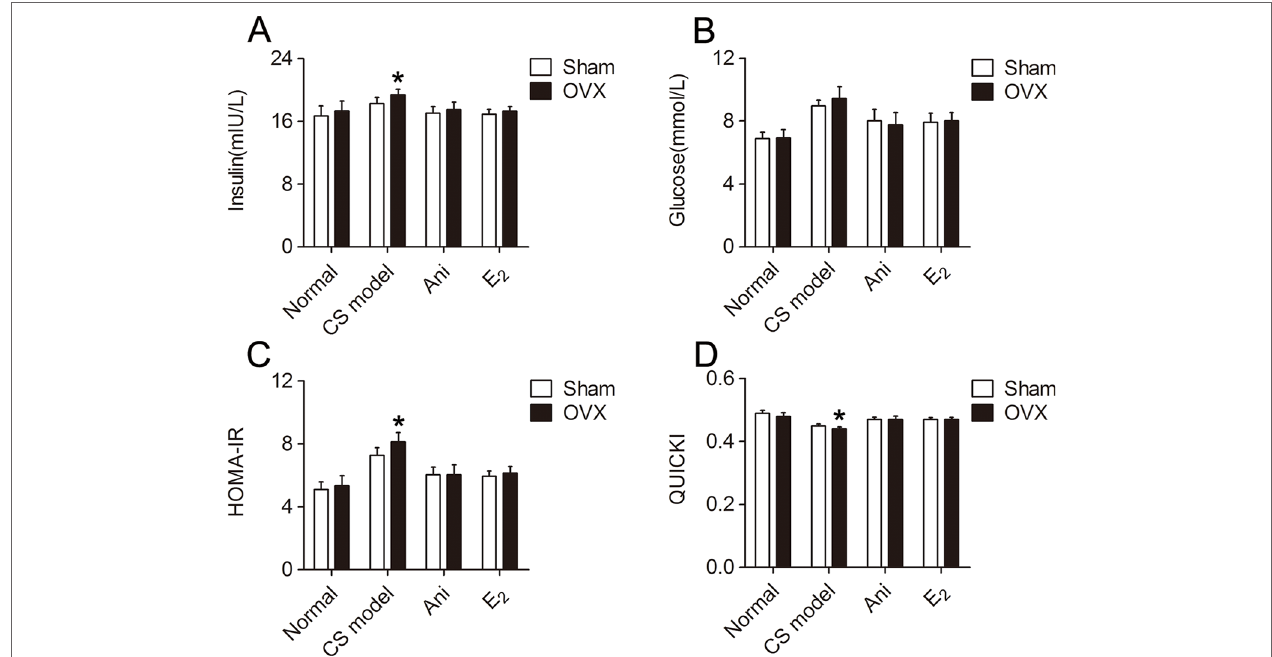
FIgURE 7 | Influences of ovariectomy (OVX) and Anisodamine (Ani)/E 2 treatment on insulin sensitivity in mice with crush syndrome (CS). Ani (28 mg/kg, i.p.) or E 2 (100 mg/kg, i.p.) was administrated at 30 min before decompression in mice with CS 2 weeks after OVX surgery or its sham operation. Blood samples were collected at 6 h after decompression. OVX elevated serum insulin level (A) and homeostasis model assessment of insulin resistance index (C) , reduced quantitative